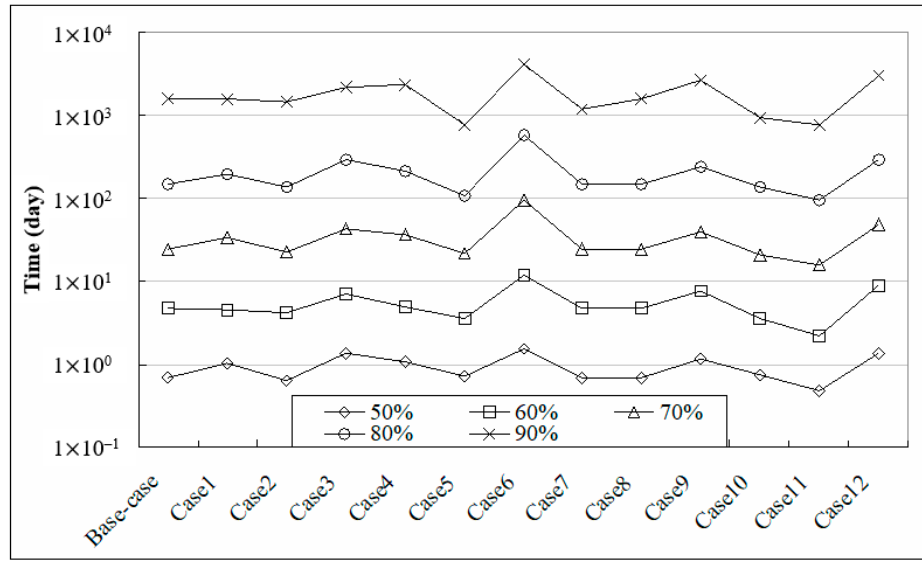
Figure 2. Required time for different percentages of head recovery.